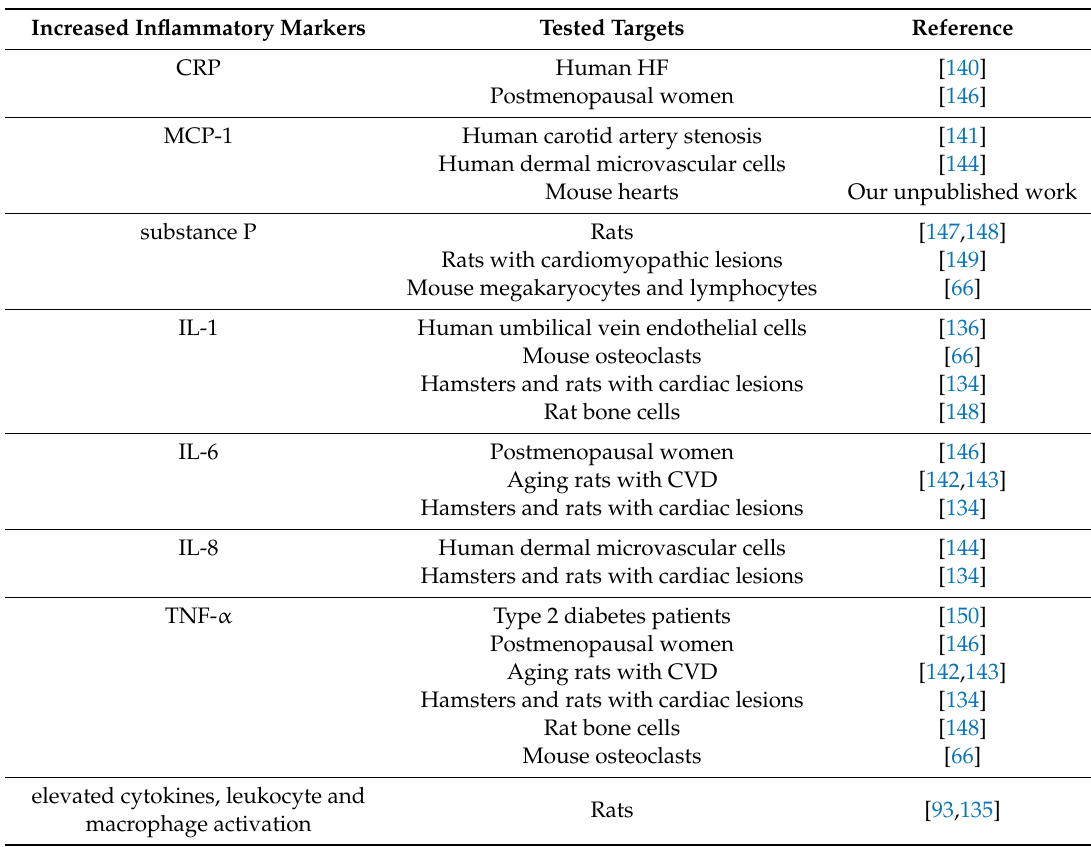
Table 1. Mg deficiency activates inflammation with increased inflammatory markers reported in clinical and animal